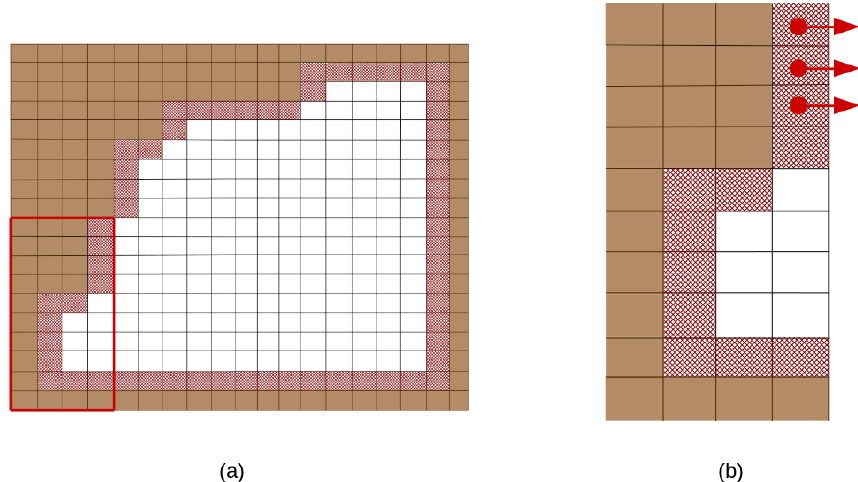
Figure 5. (a) A configuration with straight open boundaries on the eastern and southern sides and unstructured open boundaries on the western and northern sides; the red line delimits a possible MPI subdomain detailed in panel (b) . Brown cells are land cells and red hatched cells are open boundary cells. Red dots mark some T points of the open boundary ( (x i ,y i ) ) and red arrows the points orthogonal to the | boundary used in the computing of ∂φ (x,y) = (x i ,y i ) ∂n